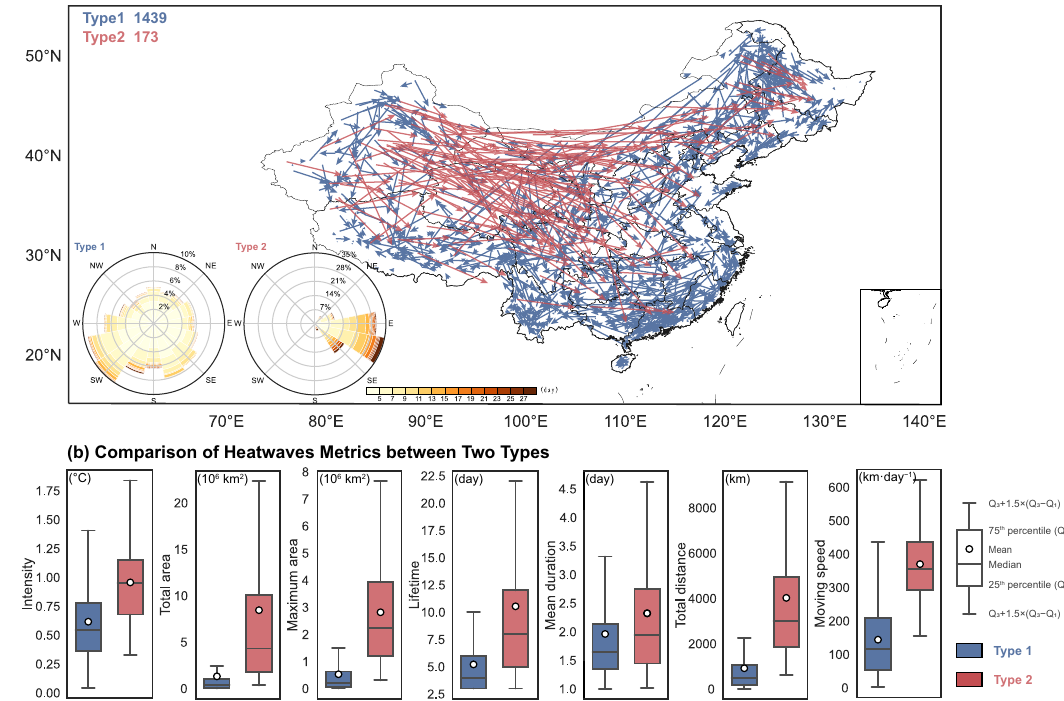
Fig. 3 Comparison of two clustered propagation patterns of contiguous heatwaves across China during 1961 – 2018. a Moving patterns of two types of contiguous heatwaves. The blue arrows in a indicate Type 1 while the red arrows indicate Type 2 and the tail (head) of each arrow indicates the centroid location of the fi rst (second) half of the event. The rose diagram in the lower left corner in ( a ) shows the directional distribution of lifetime of the two types. b Comparisons in multiple metrics between two types. The statistics in the box plots in ( b ) from the upper to lower bound represent the value of Q3 + 1.5×(Q3 – Q1), third quartile (Q3), mean (circle), median (horizontal line), fi rst quartile (Q1), and Q1 – 1.5 × (Q3 – Q1) successively. The value of Q3 – Q1 denotes the interquartile